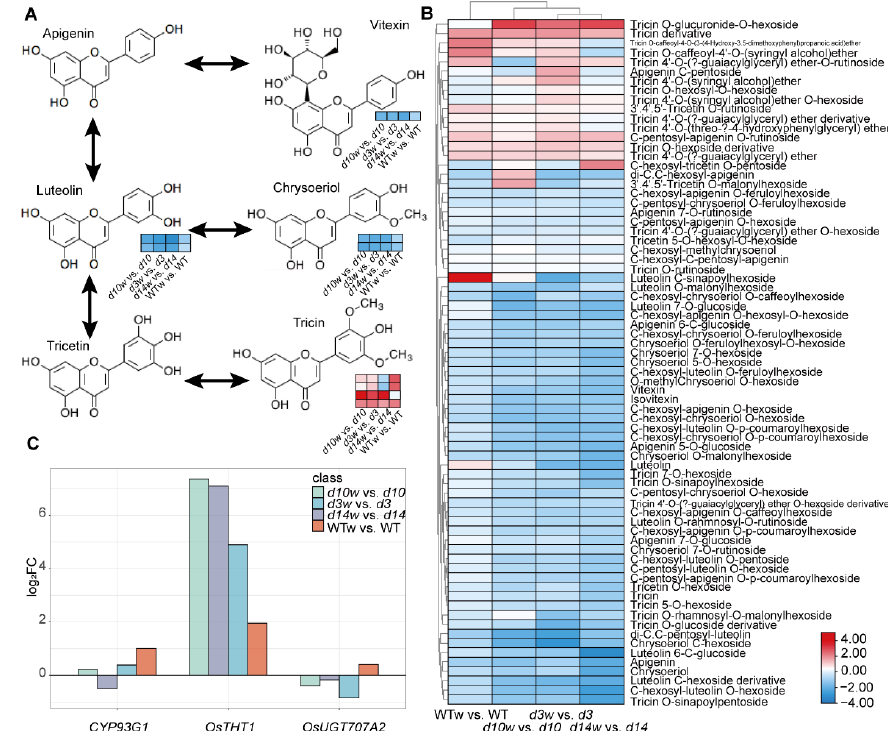
Figure 9. SLs and wound affected the flavones ’ pathway. ( A ) DAMs were mapped to the flavone pathway. The small heatmap in each section of the diagram shows the DAMs mapped to the pathway, and a small square indicates a metabolite. ( B ) Heatmaps of flavones contents. ( C ) Expression levels of three genes related to flavones in SLs mutants and wild-type plants. Heatmaps were drawn using the log 2 (FC) value obtained from the pairwise comparison of samples. Red and blue indicated upregulation and downregulation, respectively.